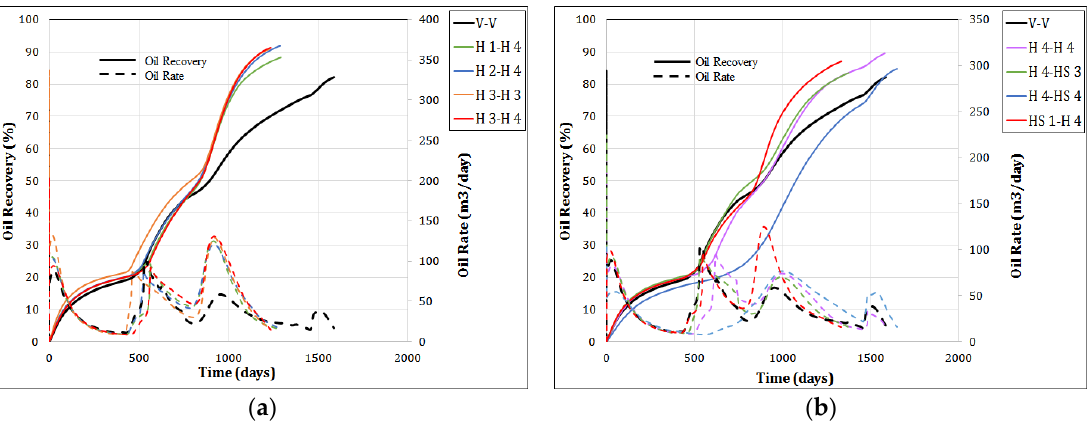
Figure 3. Oil production performance of several well combinations belonging to Category B: ( a ) H-H group; ( b ) H-H, H-HS and HS-H groups.